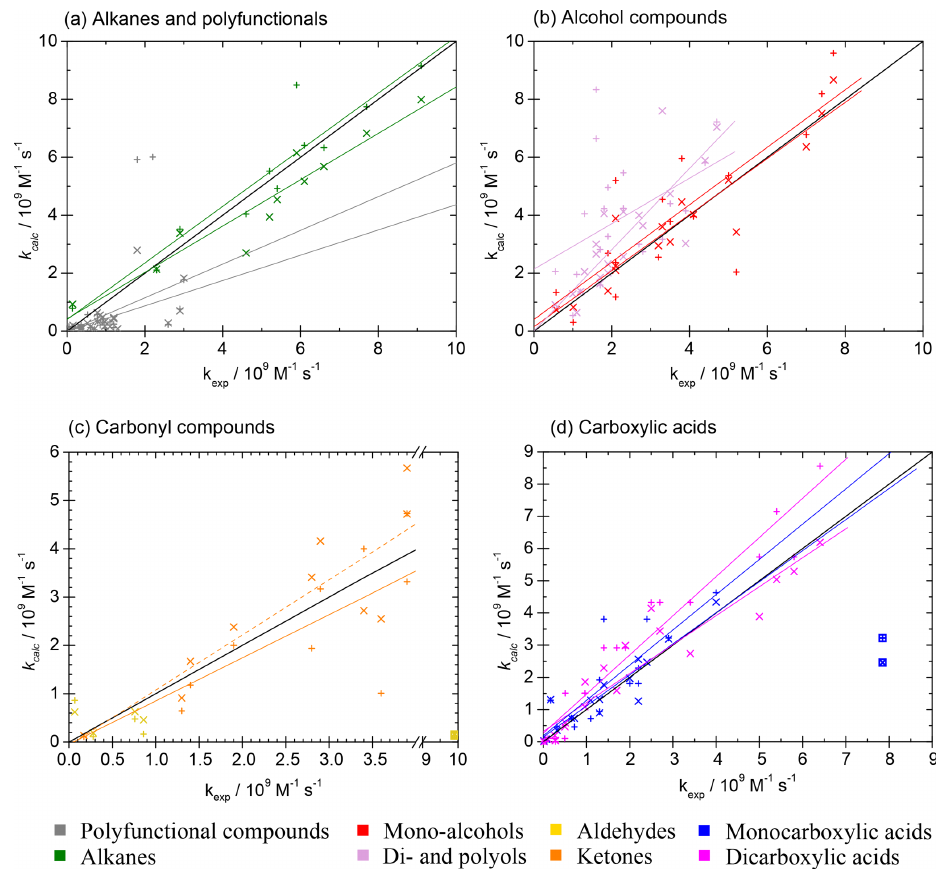
Figure 8. Scatter plots of predicted versus experimental data for the two SARs by Doussin and Monod (2013) and Minakata et al. (2009). Oblique crosses indicate predicted data by the SAR of Doussin and Monod (2013), with solid regression lines in the same colour. Upright crosses are data predicted with the SAR by Minakata et al. (2009), and dashed regression lines are in the same colour. The boxed value in panel (c) has been excluded as an outlier in the regressions. Regressions in panel (c) include both aldehyde and ketone data. Parameters for regression lines are given in Tables S13 and S14 in the ESM for the data by Doussin and Monod (2013) and Minakata et al. (2009),